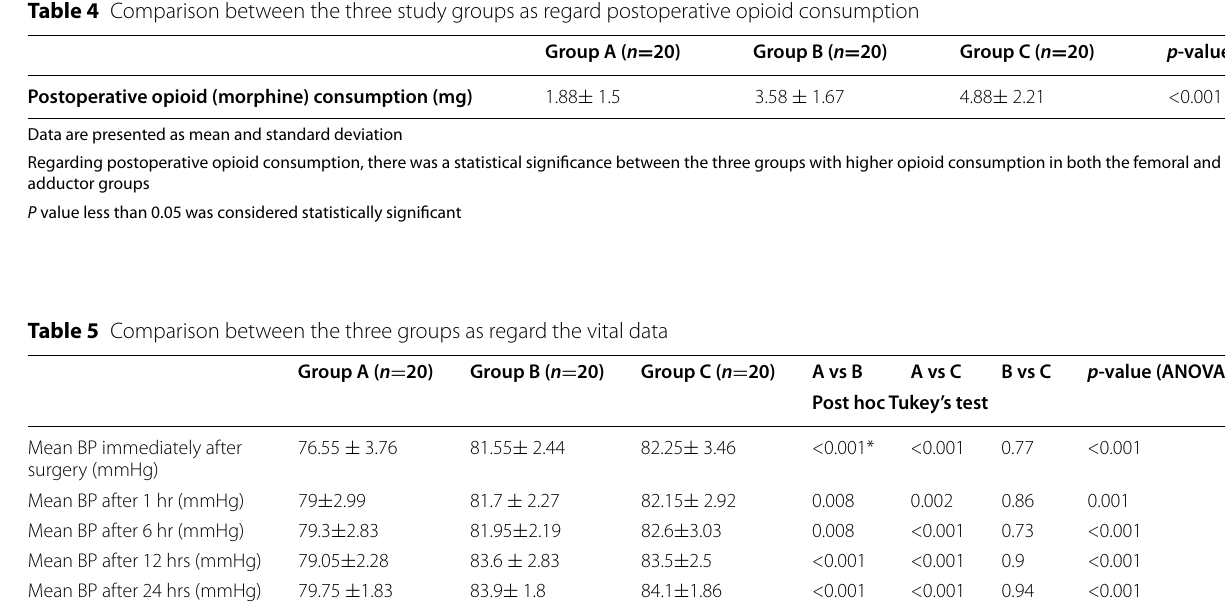
Data are presented as mean and standard deviation Post-operative vital data events were compared between the three groups, mean blood pressure was lower in the epidural group (group A) compared to the femoral and adductor groups (group B and C). Although, there was no significant difference between the femoral & adductor groups BP Blood pressure P value less than 0.05 was considered statistically significant. pairwise comparison within the ANOVA data was done using post hoc Tukey’s